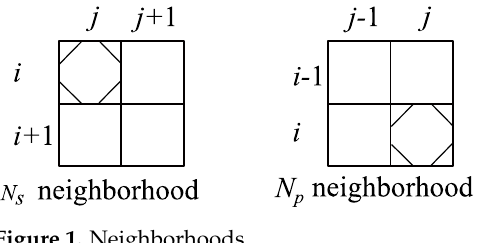
Figure 1. Figure 1. Neighborhoods.